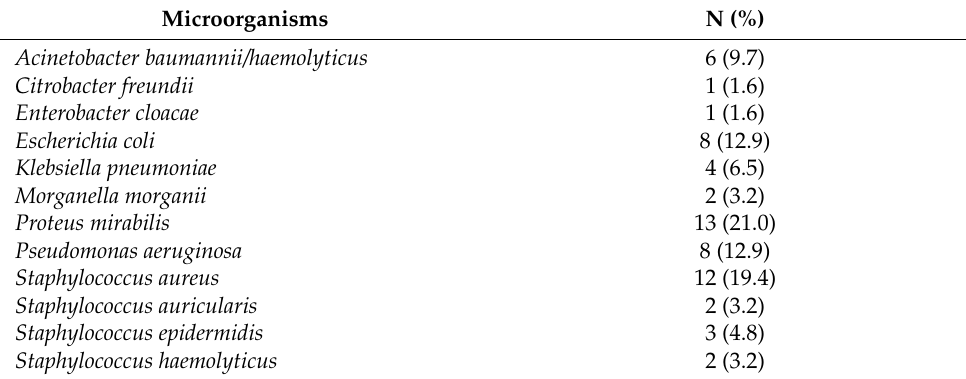
Table 5. Distribution of microorganisms with ≥ 6 resistances.